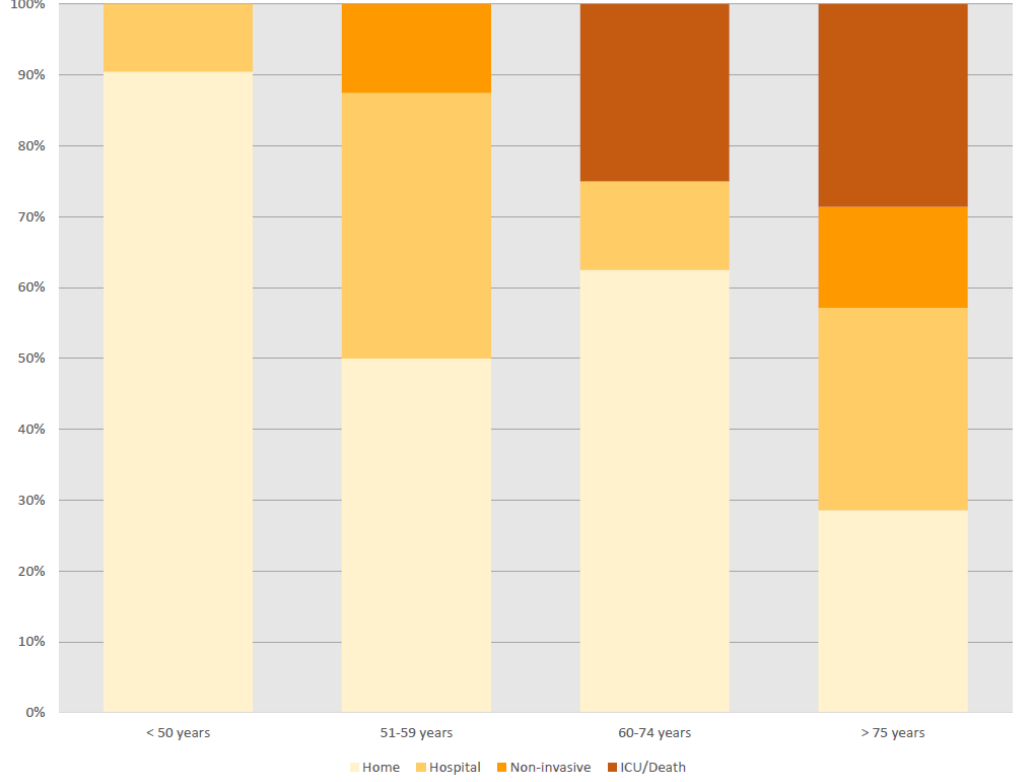
Figure 1. Individual outcomes of the 45 patients with sarcoidosis ordered from the youngest to the older age at diagnosis of SARS-CoV-2 infection.